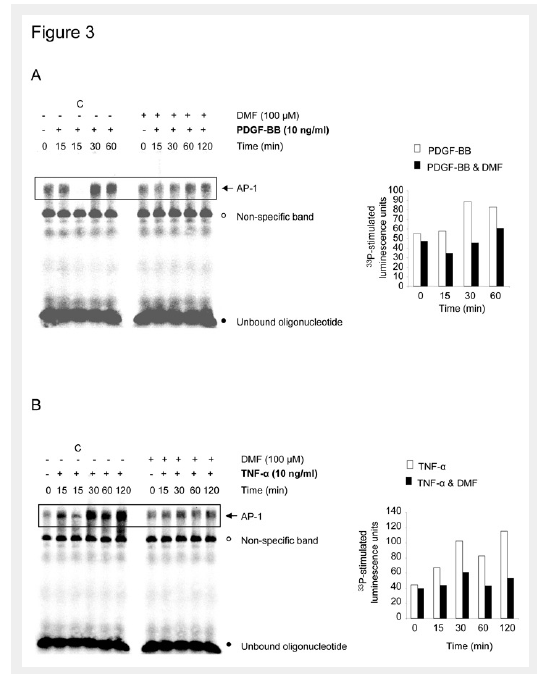
unlabeled oligonucleotides competed off the specific AP-1/DNA complexes (C: